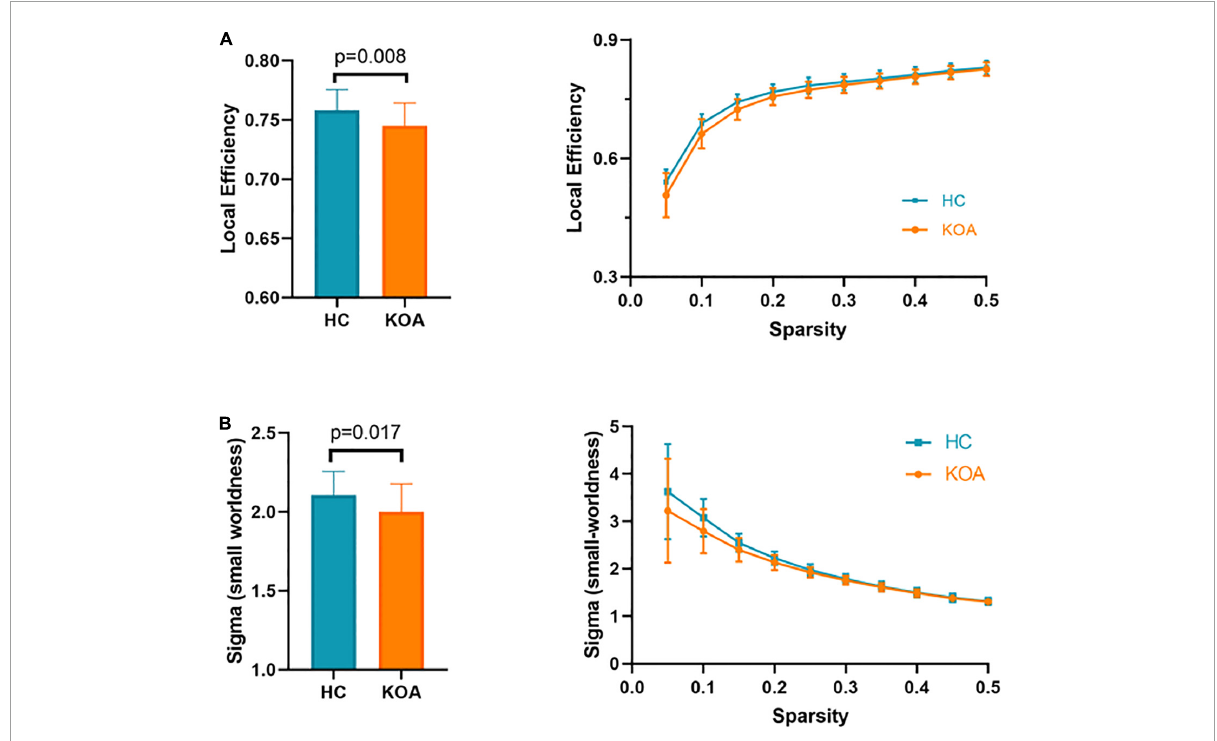
FIGURE3 Topological properties. (A) Local efficiency. (B) Sigma small-worldness.